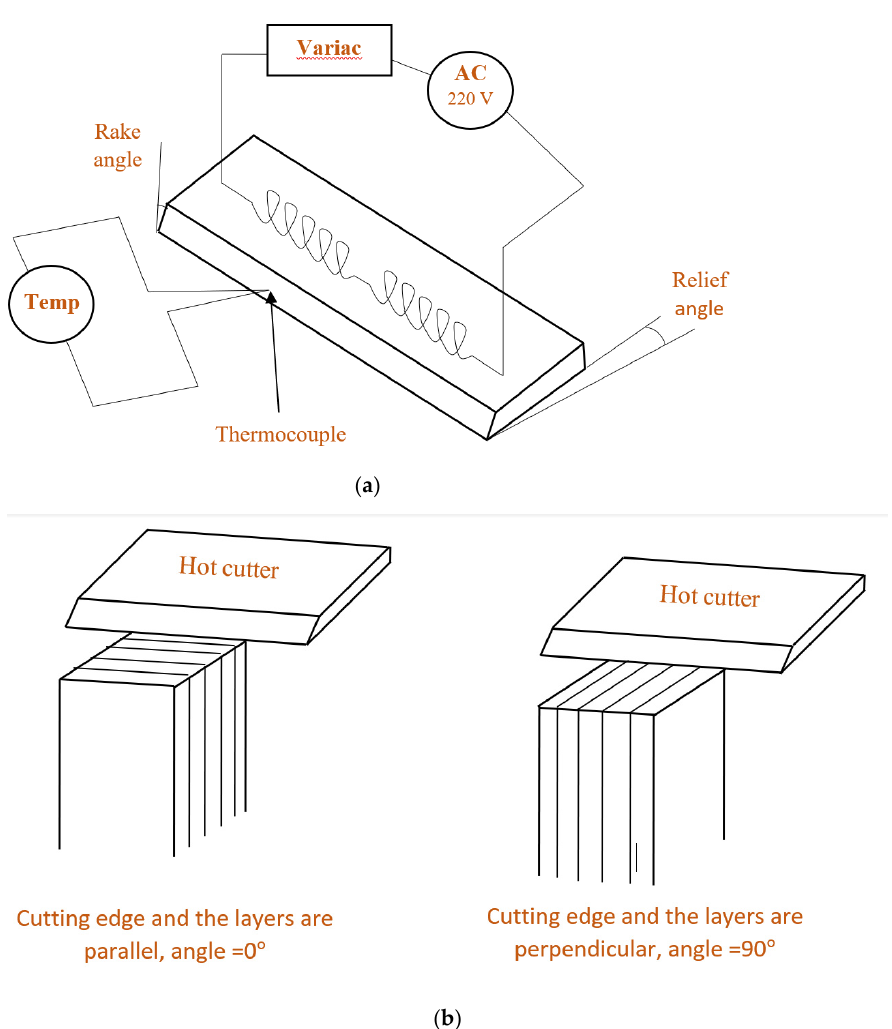
Figure 13. Machining with the heated cutter: ( a ) shape of the cutter and ( b ) direction of the ma- chining.